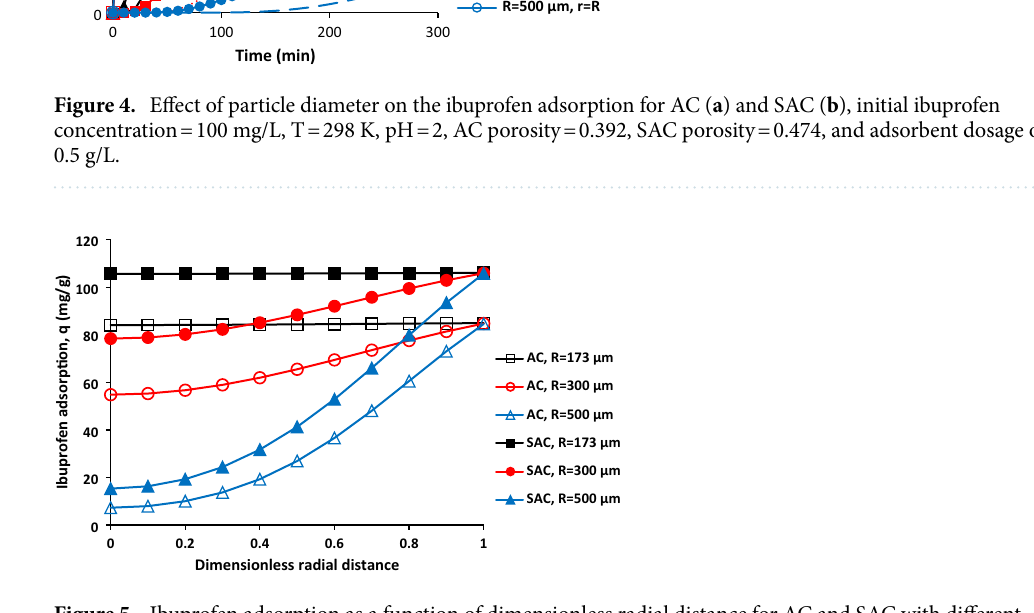
Figure 5. Ibuprofen adsorption as a function of dimensionless radial distance for AC and SAC with different particle diameters, initial ibuprofen concentration = 100 mg/L, T = 298 K, pH = 2, AC porosity = 0.392, SAC porosity = 0.474, and adsorbent dosage of 0.5